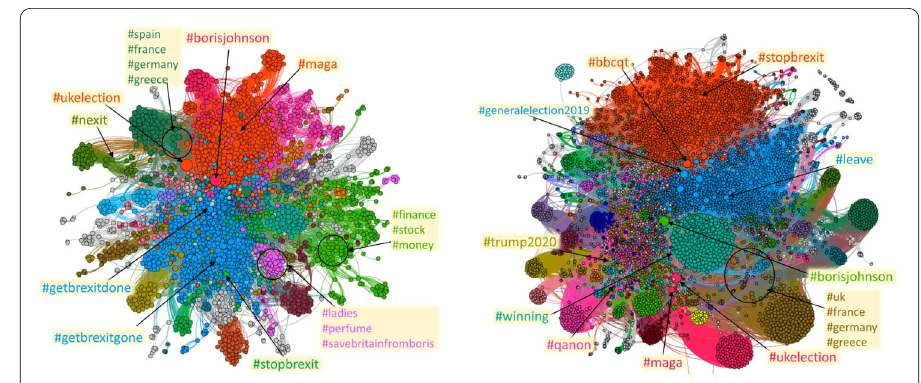
Figure 7 The backbones of the networks of hashtags and bots (left) and hashtags and suspended users (right) linked by retweets for the whole period of our dataset. Both networks show a modular structure probably due to the coordination of the automated users: the depicted partitions have a modularity of 0.73 (left) and 0.78 (right). In the bots’ network the Brexit discussion appears together in the blue community, while for the suspended users two separate groups are pro-Euro (orange) and pro-Brexit (blue). In both cases, Trump-related hashtags are very common